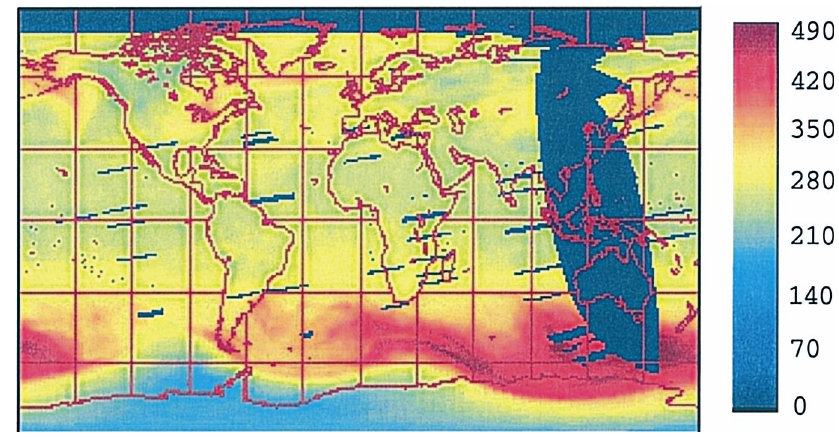
Fig. 2. Total TOMS ozone field in Dobson Units, October 5, 1988. Interval is 10 DU. The zero value corresponds to missing